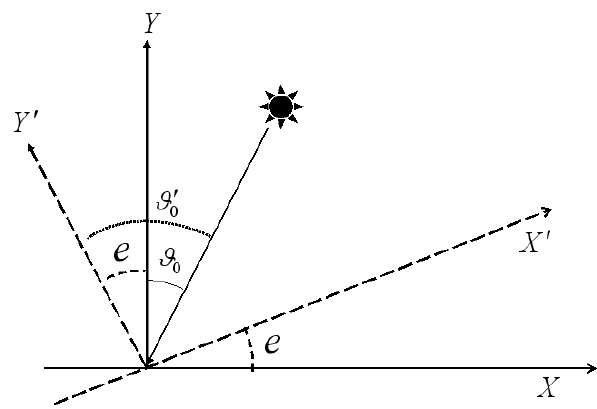
Fig. 5. A representation of incidence and viewing angles for plane to slope